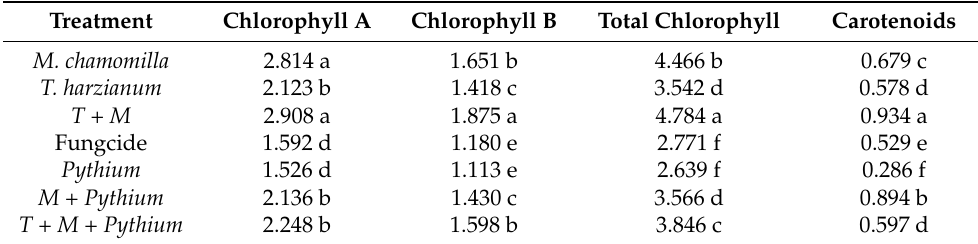
Different letters within each column means values are significantly different at p ≤